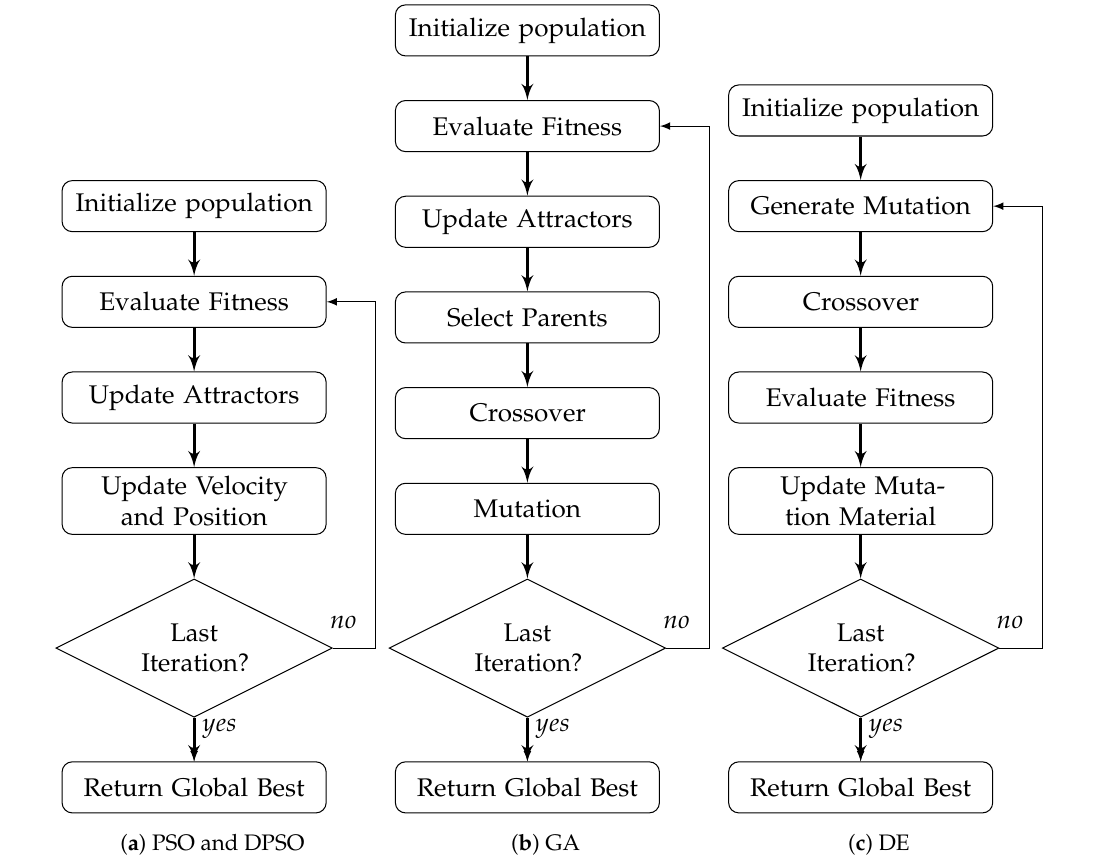
Figure 1. Flow diagrams depicting the process of each